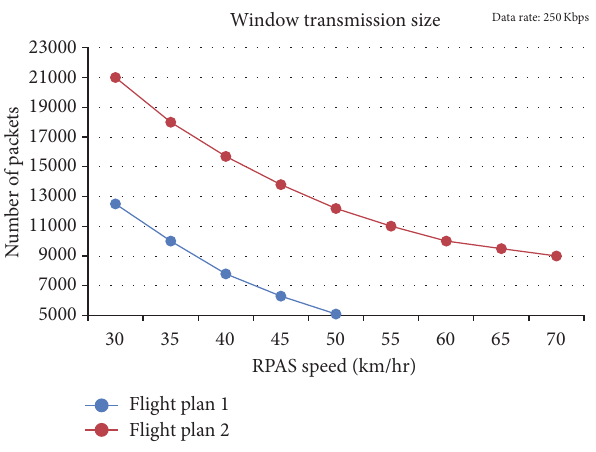
Figure 7: Transmission window size.